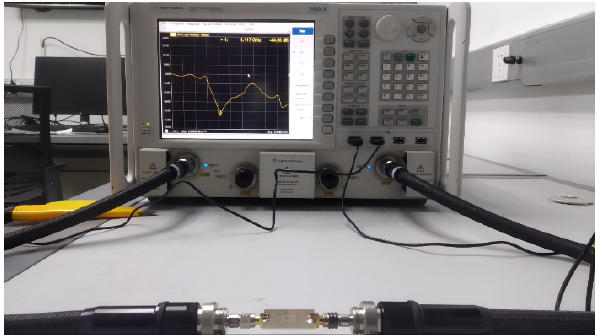
Figure 11. Measurement of proposed DS-CSRR-based sensor using network analyser N5224B.